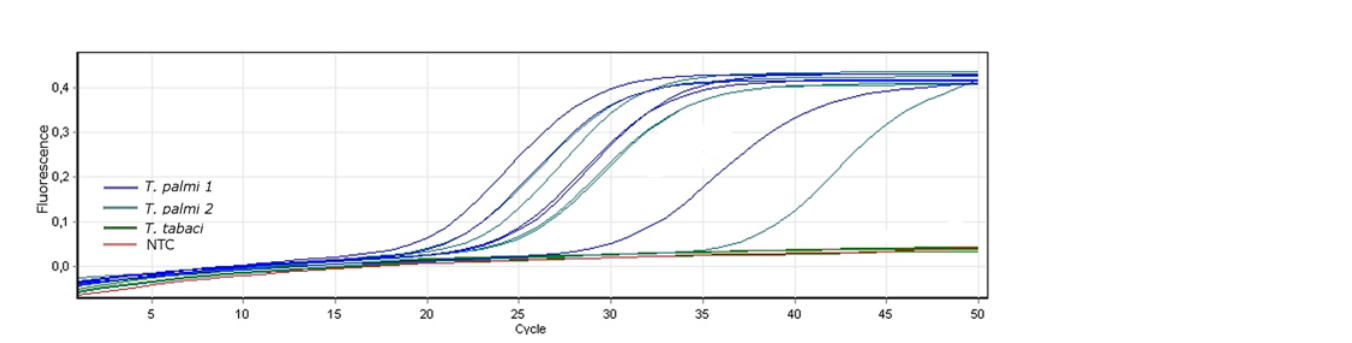
Fig 6. Results of LAMP reactions using real-time monitoring without DNA extraction. T.p. — T . palmi , T.t. — T . tabaci . NTC — no template